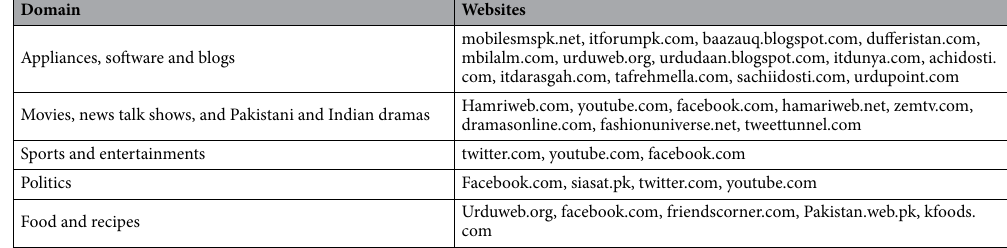
Table 2. Online collection sources for Urdu user